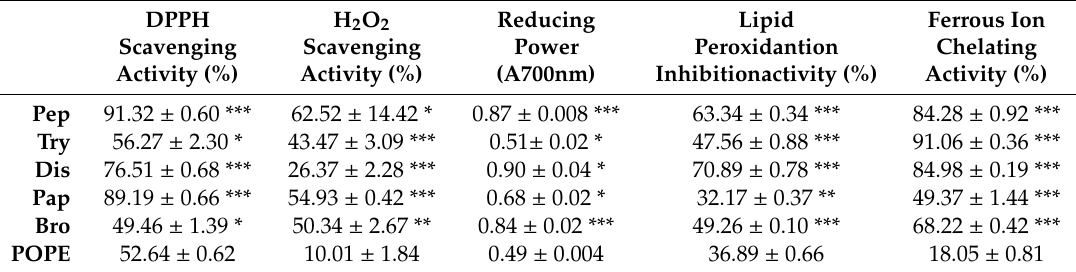
Table 3. Comparison of in vitro antioxidant e ff ects of P. ostreatus protein hydrolysate: Pep, Pepsin-treated; Try, trypsin-treated; Dis, dispase-treated; Pap, papain-treated and Bro, bromelin-treated. The values are presented as the mean ± SD.